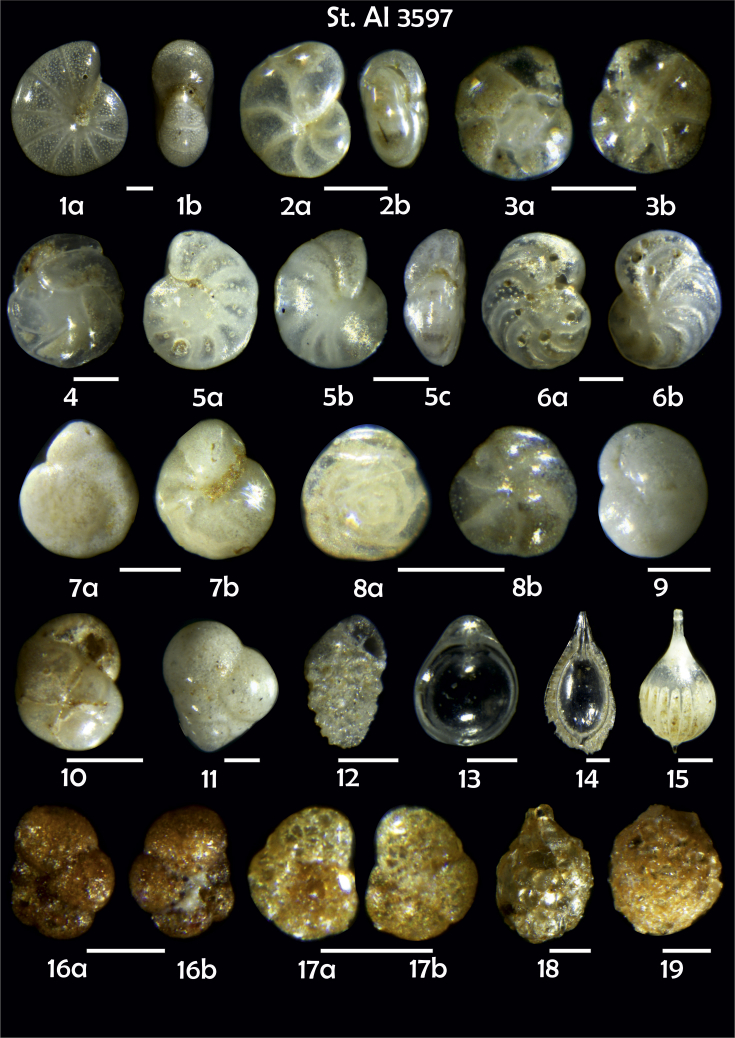
Station 35971Melonis barleeanus,a side view, b apertural view. 2Pullenia sp., a side view, b apertural view. 3Epistominella exigua, a spiral view, b umbilical view. 4Cassidulina teretis. 5Cibicidoides wuellerstorfi, a umbilical view, b spiral view, c apertural view. 6C. wuellerstorfi, a umbilical view, b spiral view. 7Hanseniska sp.?, a spiral view, b umbilical view. 8Alabaminella weddellensis, a spiral view, b umbilical view. 9Cassidulina reniforme. 10Globacassidulina subglobosa. 11Eggerella bradyi. 12Bolivina pseudoplicata. 13, 14Fissurina spp. 15Lagena sp. 16 ?, a, b side view. 17Trochammina inflata, a spiral view, b umbilical view. 18Saccammina sphaerica. 19Psammosphaera fusca. Scale 100 μm.